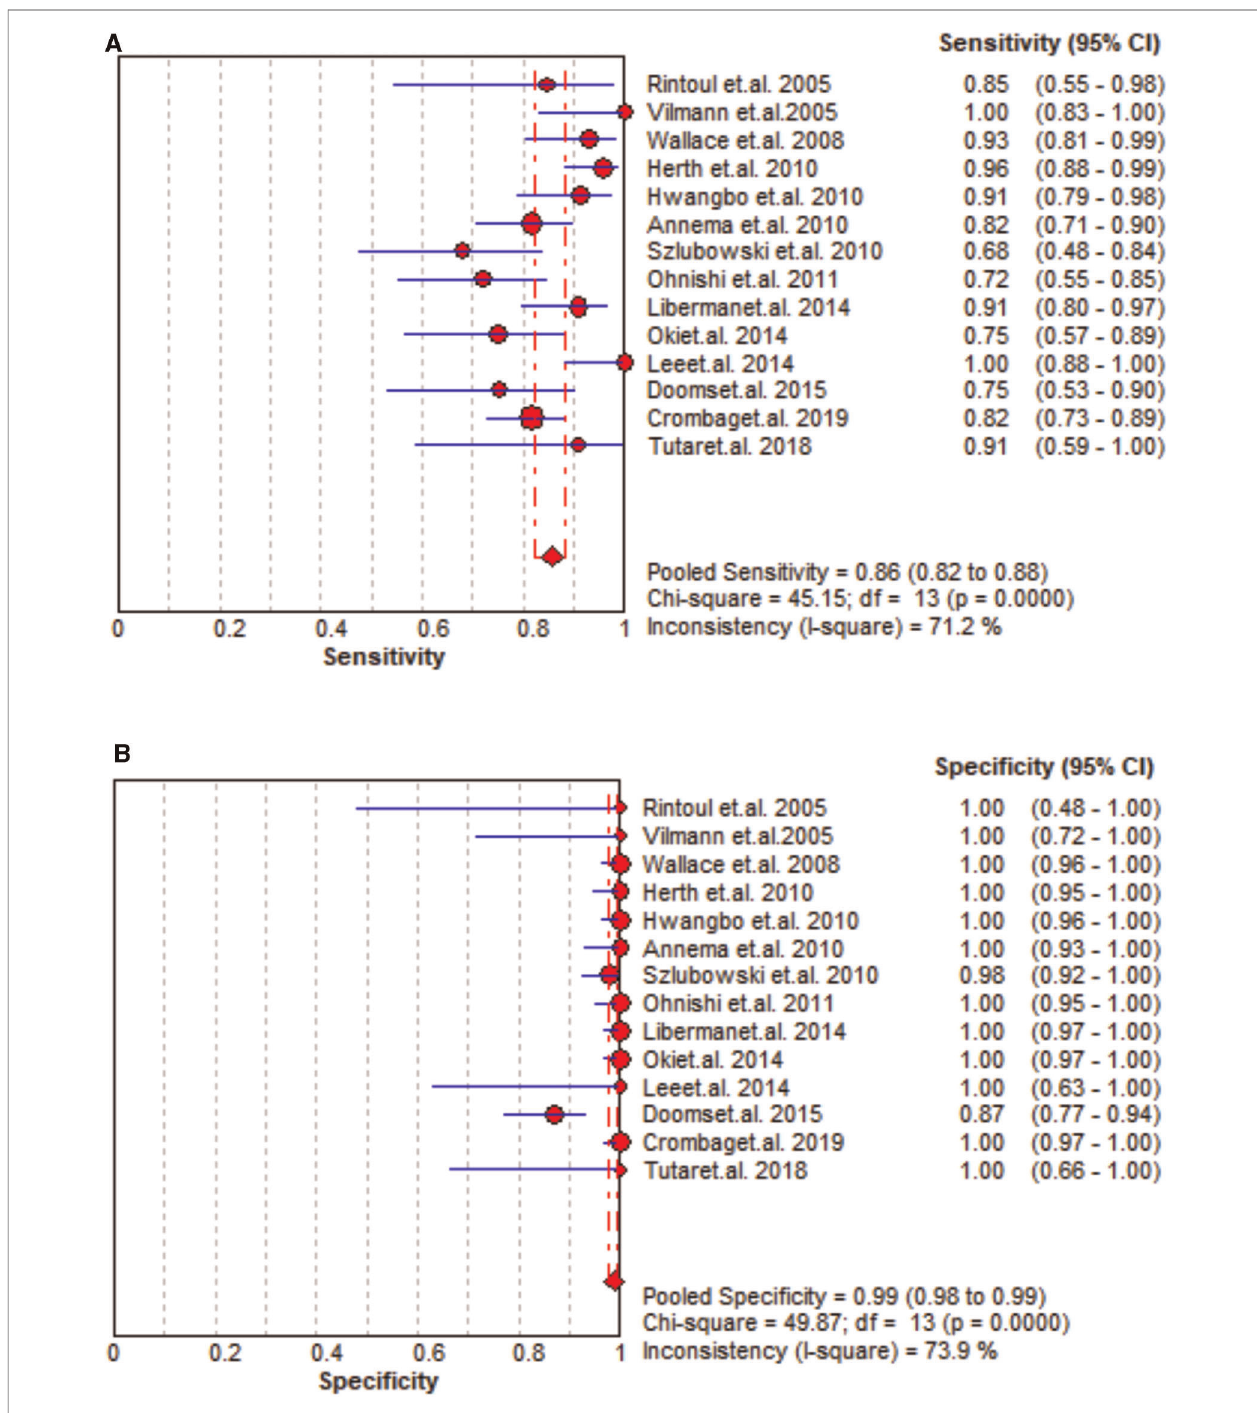
FIGURE 4 | Summary of pooled sensitivity and speci fi city of the combination of EBUS and